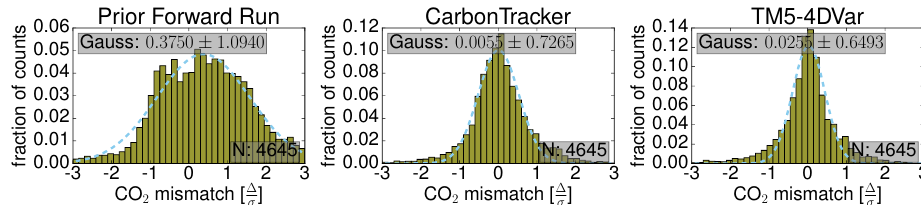
Figure 2. Histograms of the mismatch between measured and modeled CO 2 concentrations for all assimilated measurements using prior fluxes, CarbonTracker optimized fluxes and TM5-4DVar optimized fluxes. The histograms show residuals for one year (3 April 2009 to 2 April 2010) which are normalized by the estimated representativeness error. The line overlying the histograms is a fit of a Gauss function to the histogram. The parameters in the top left show the bias and standard deviation of the Gaussian. The bottom right shows the number of measurements which were accumulated into the histogram.